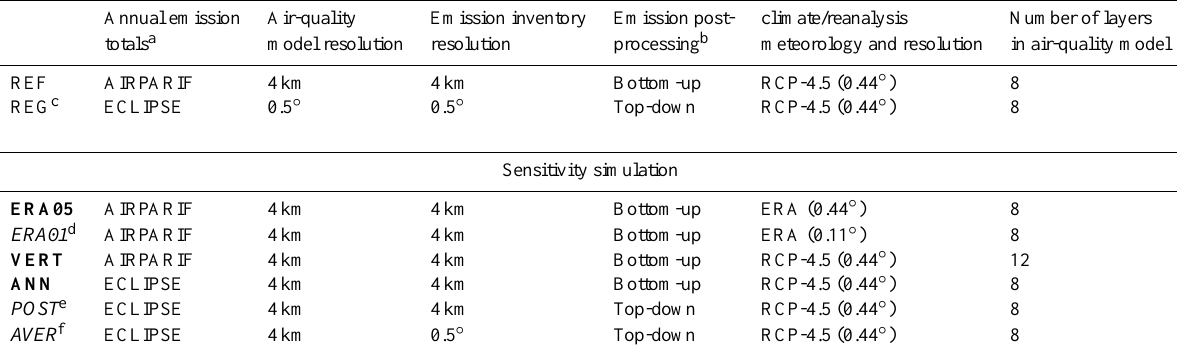
Table 1. Parameterization of the different sets of simulations presented in the paper. Changes with respect to the REF case are marked in bold. Changes with respect to a simulation other than REF are marked in